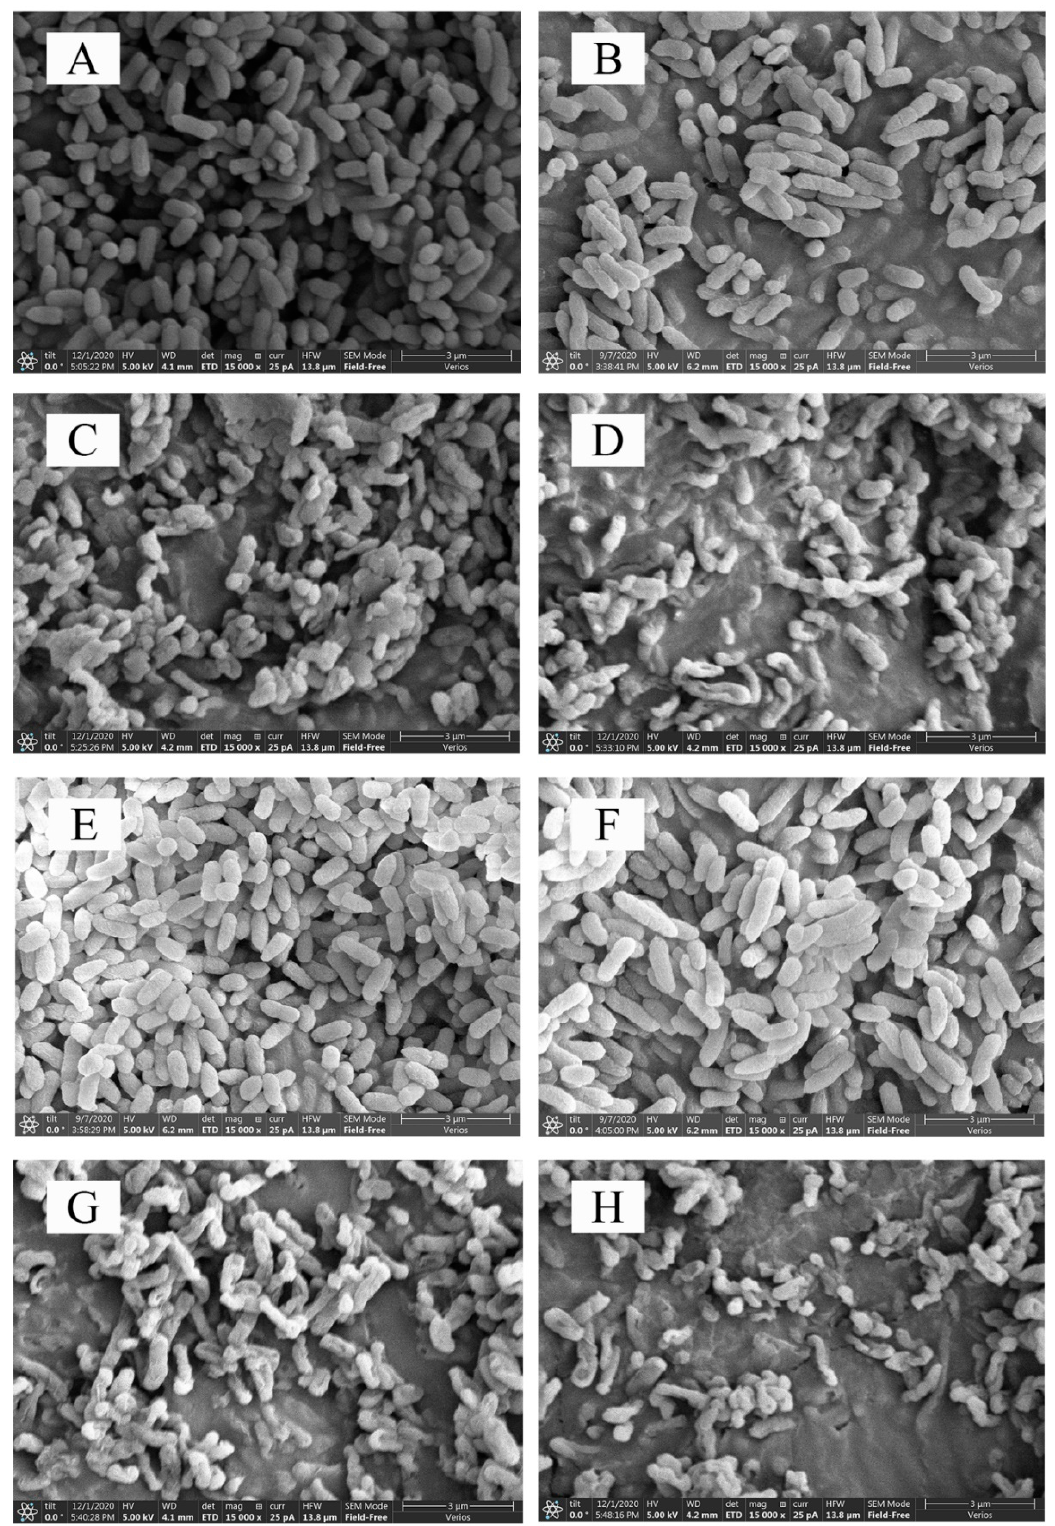
Figure 2. Scanning electron microphotographs (SEM) of P. lundensis . ( A ) P. lundensis untreated for 12 h, ( B ) treated with 2% ethanol for 12 h, ( C ) treated with 3-carene at 1 × MIC for 12 h, ( D ) treated with 3-carene at 2 × MIC for 12 h, ( E ) untreated for 24 h, ( F ) treated with 2% ethanol for 24 h, ( G ) treated with 3-carene at 1 × MIC for 24 h, and ( H ) treated with 3-carene at 2 × MIC for 24 h.